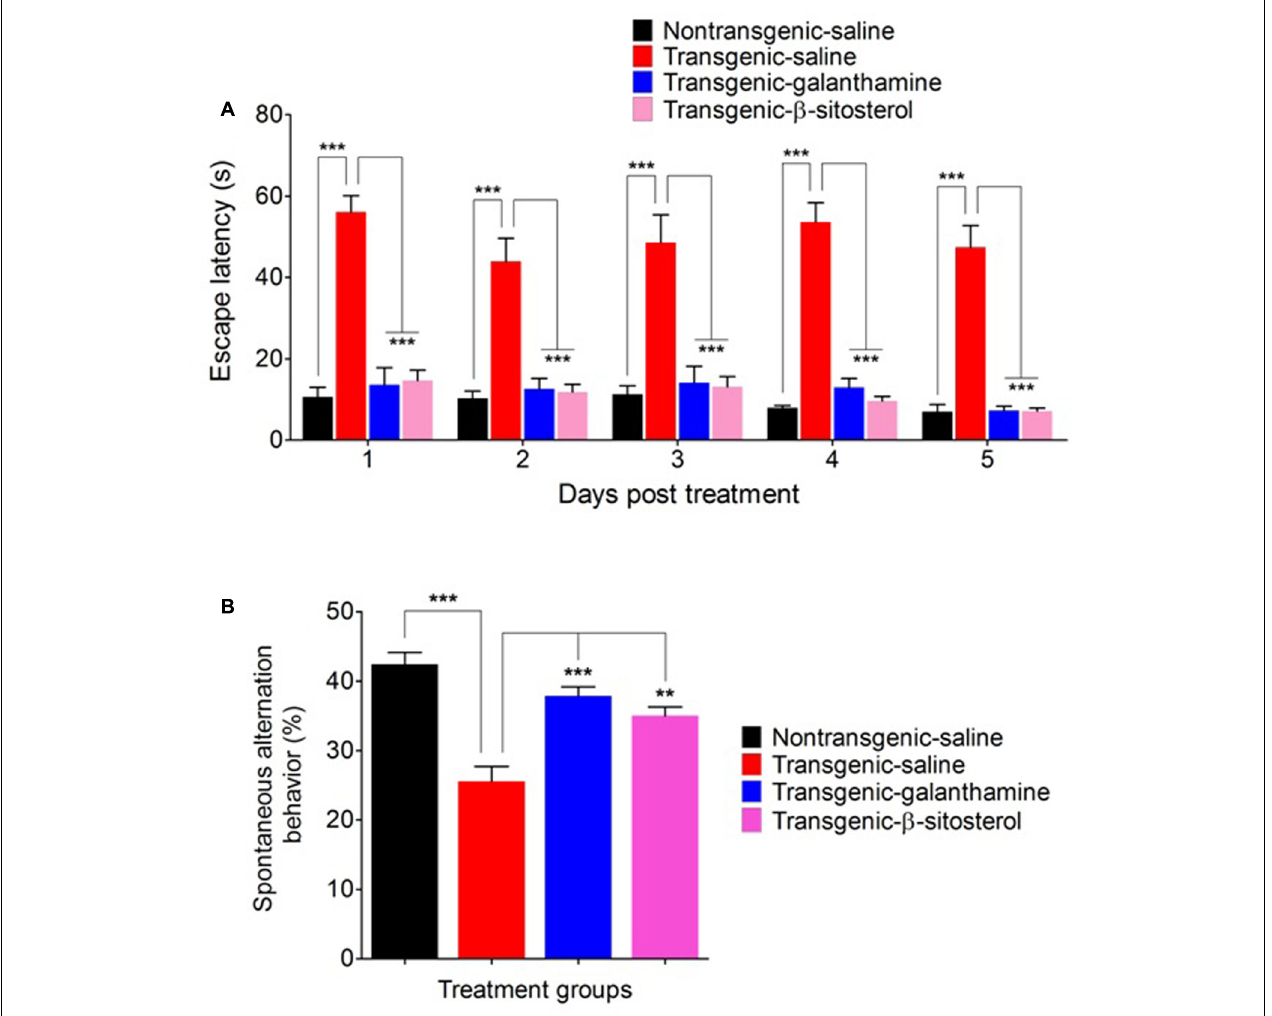
FIGURE 4 | Effect of galanthamine and β -sitosterol on escape latency (A) and percent spontaneous alternation behavior (B) in the Y maze test in different groups of animals; Non-transgenic-saline, Transgenic-saline, Transgenic- β -sitosterol and Transgenic-galanthamine. Bars represent mean ± SEM. ∗∗ P < 0.01, ∗∗∗ P < 0.001, two-way repeated measures ANOVA followed by post hoc Bonferroni’s analysis or one-way ANOVA followed by post hoc Tukey’s multiple comparison test.